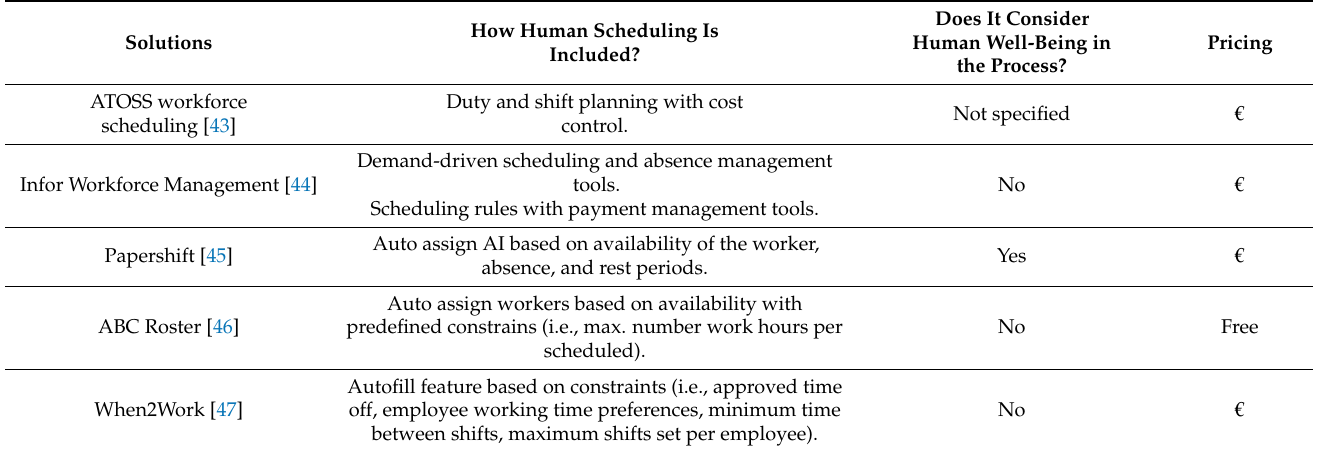
Table 2. Shopfloor supporter HR management